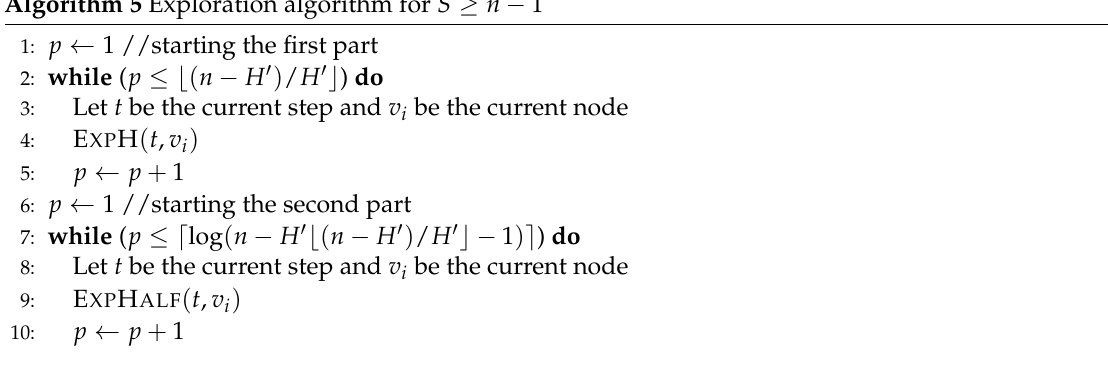
Algorithm 5 Exploration algorithm for S ≥ n −